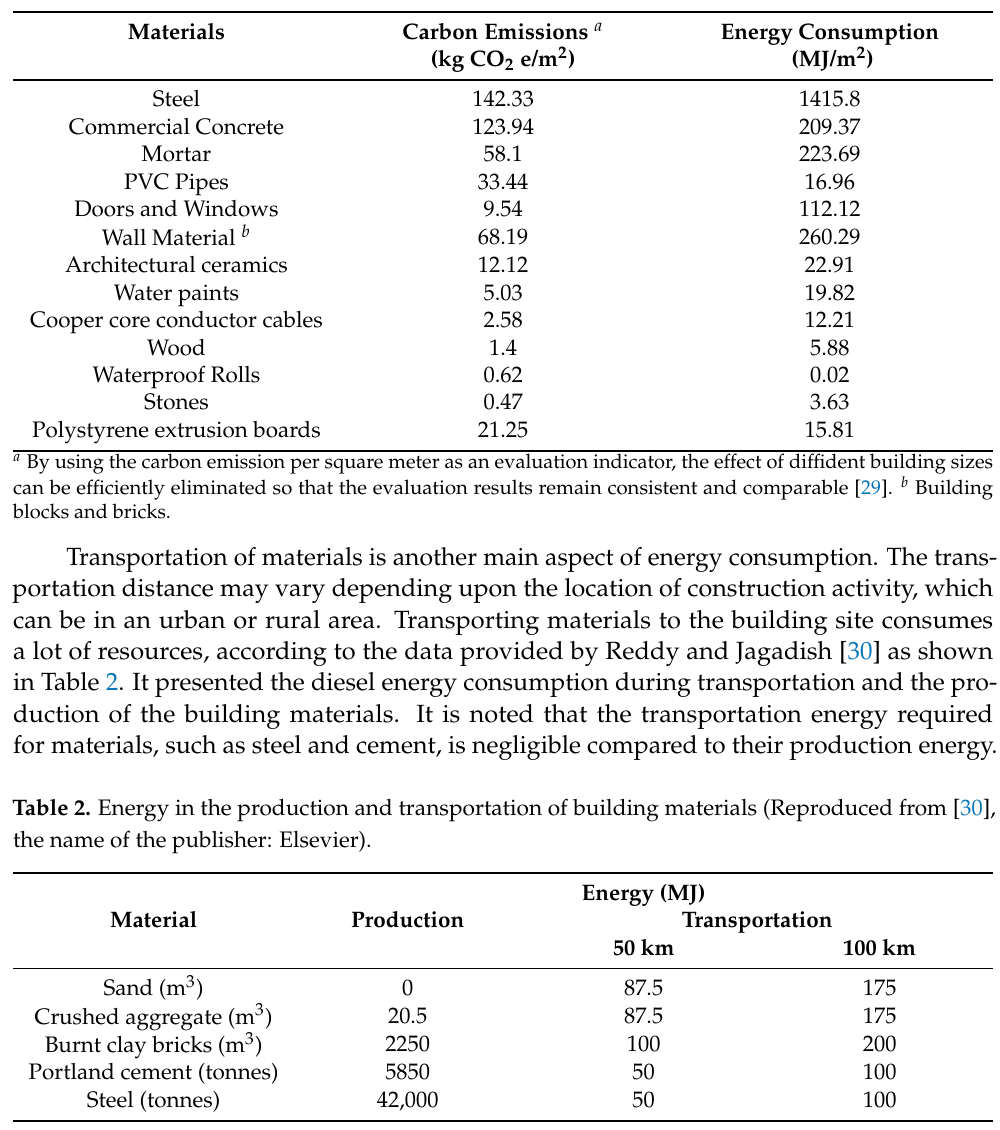
Table 1. Embodied carbon emissions and the energy consumption of primary building materials (Re- produced from [21], the name of the publisher: Elsevier).